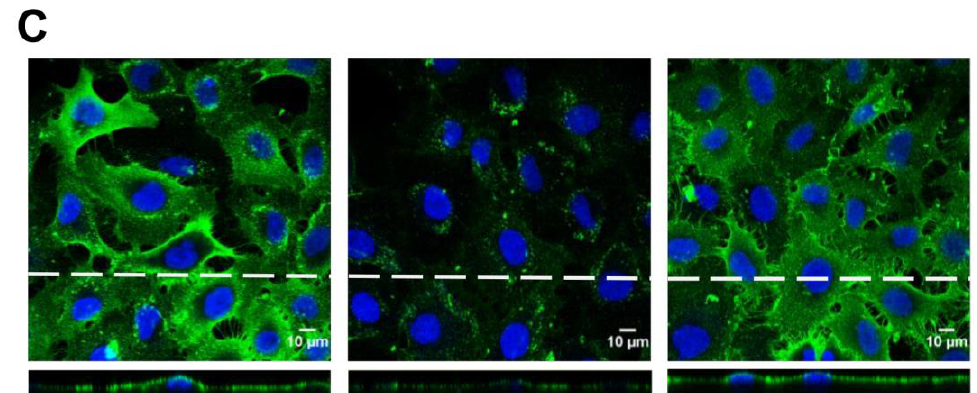
Figure 3. ECX prevents heparinase I induced damage to the endothelial glycocalyx (eGC). ( A ) Differences in eGC thickness in living endothelial cells (EA.hy926) measured via atomic force microscopy following the addition of 45 µg/mL albumin (Alb.), 1 U/mL heparinase I (Hepar. I) and/or ECX 1:1000 to solvent (HEPES buffer). Each dot represents the mean of 4 to 8 force-distance curves per cell and a minimum of 15 cells, data are presented as mean ± SEM, n = 3 independent experiments (Exp.). ( B , C ) Representative immunofluorescence images and fluorescence intensity analyses of heparan sulfate staining after incubation with albumin (45 µ g/mL), heparinase I (1 U/mL) and/or ECX 1:1000), n = 3. Data are presented as mean ± SEM percentage compared to control ( C left picture). (Top) Z-projection and (bottom) cross-sectional images of stack along the dashed lines. Bar = 10 µ m. blue = DAPI (4 (cid:48) ,6-diamidino-2-phenylindole), green = heparan sulfate. In all experiments (Exp.), the incubation time was 60 min.